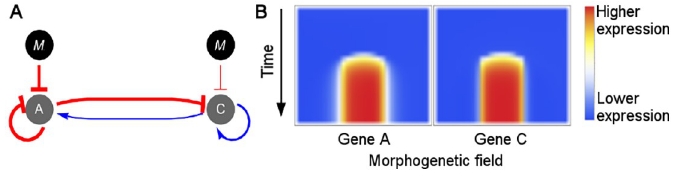
Fig 8. Expression dynamics of topology 9. (A) Network topology number 9. Although this topology consists only of two genes, it display a striped pattern of gene expression for both of them as can be observed in (B). (B) Spatiotemporal expression profile of a GRN with topology 9. Gene B is not shown as it was lost in this topology in the evolutionary process simulated by the search space algorithm.